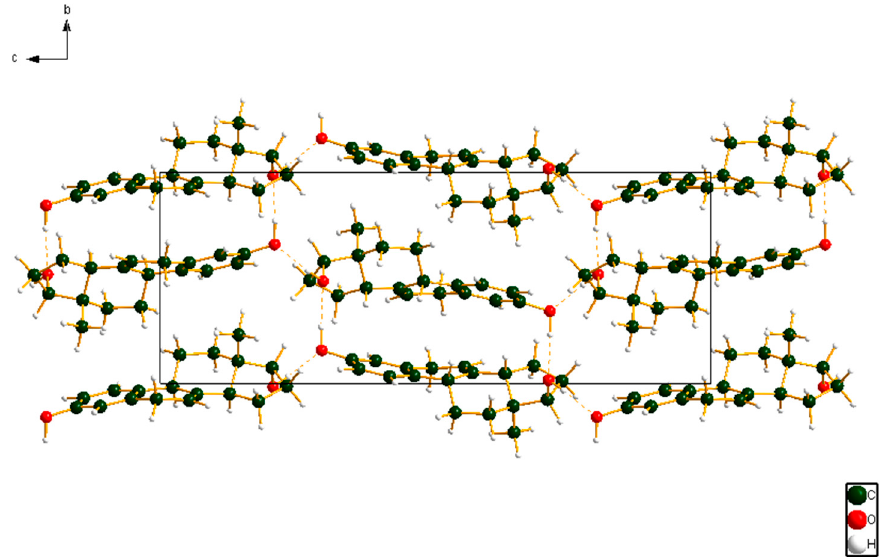
Figure 8. The crystal structure of 17 α -dihydroequilin, viewed down the a -axis. The hydrogen bonds are indicated by dashed lines.